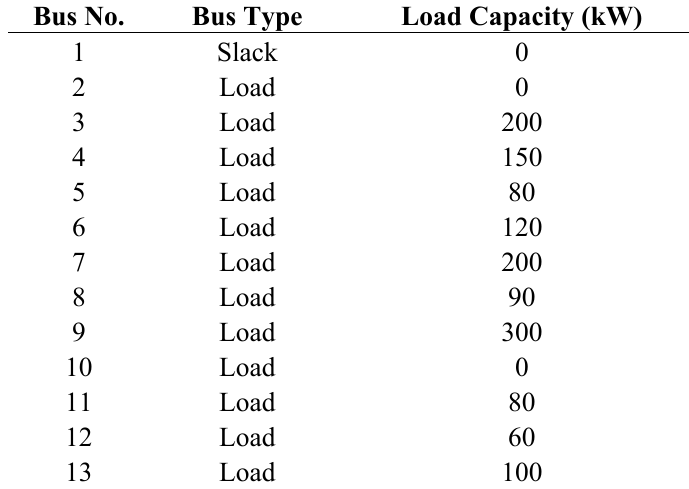
Table 1. Load data for the test system.